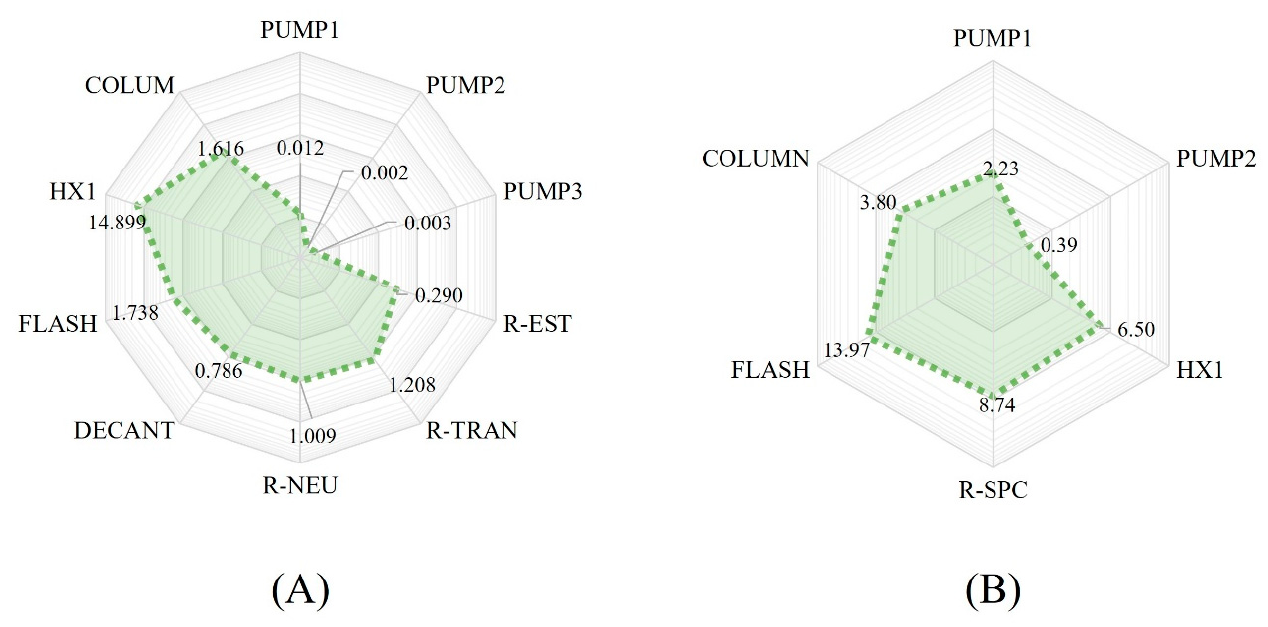
Figure 5. Exergy destruction by operation in each biodiesel production process (kW). ( A ) Alkaline process, ( B ) Supercritical process.